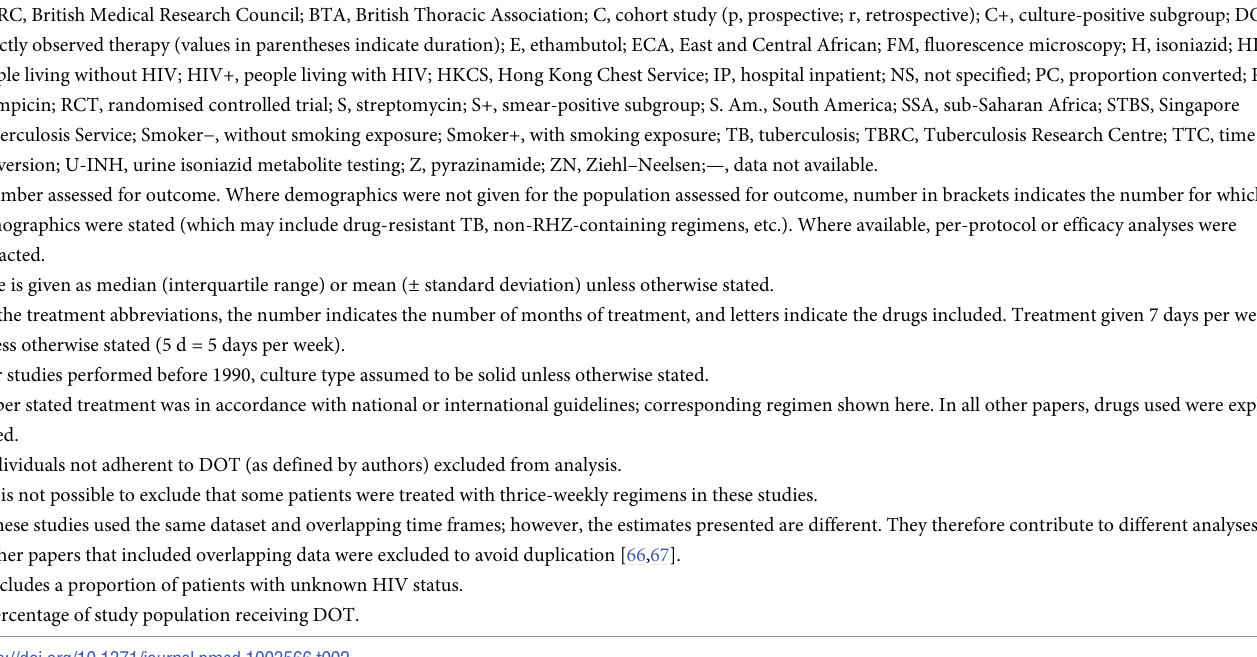
culture medium in Table 5. All 6 studies reporting solid TTC data included only smear-posi- tive patients at baseline. The median TTC ranged from 35 to 49 days, and the mean TTC ran- ged from 24 to 46 days. Four studies reported a summary estimate of liquid TTC. Median TTC ranged from 40 to 59 days among baseline smear-positive patients. One study stratified liquid culture TTC by smear status, with a median TTC of 19 days in baseline smear-negative patients compared to 40 days for smear-positive